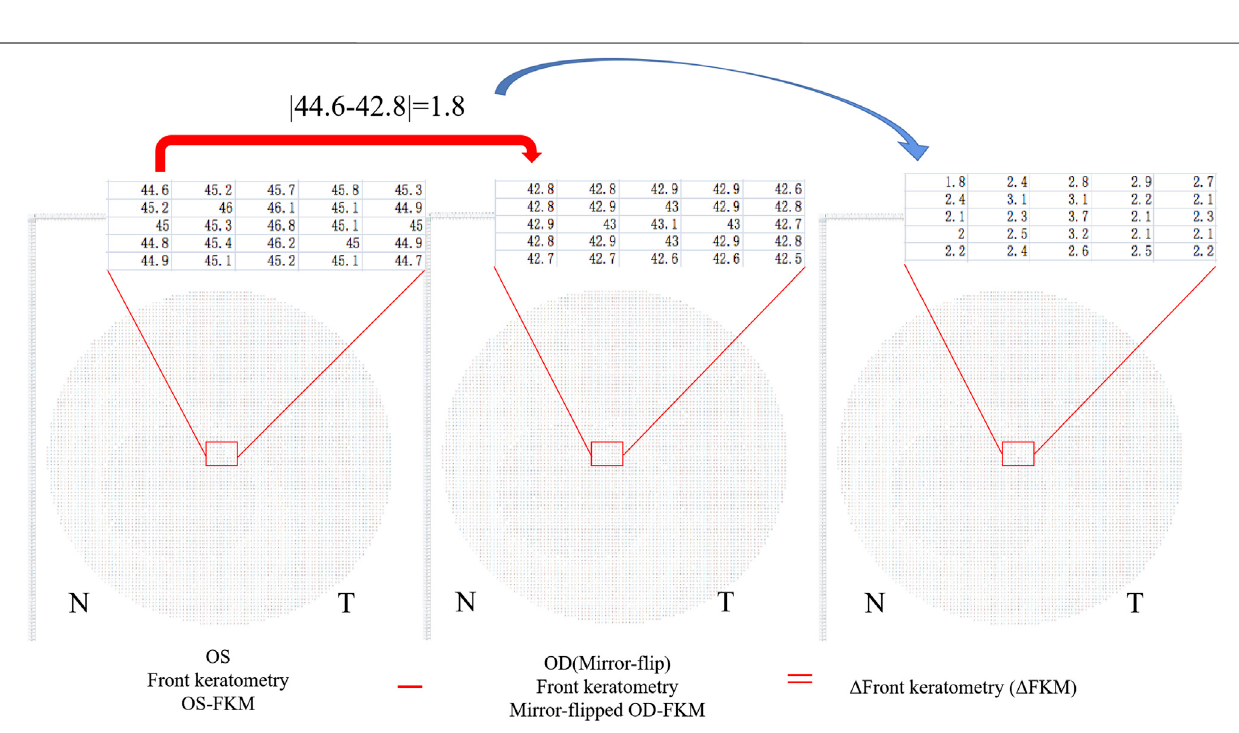
Frontiers in Bioengineering and Biotechnology |